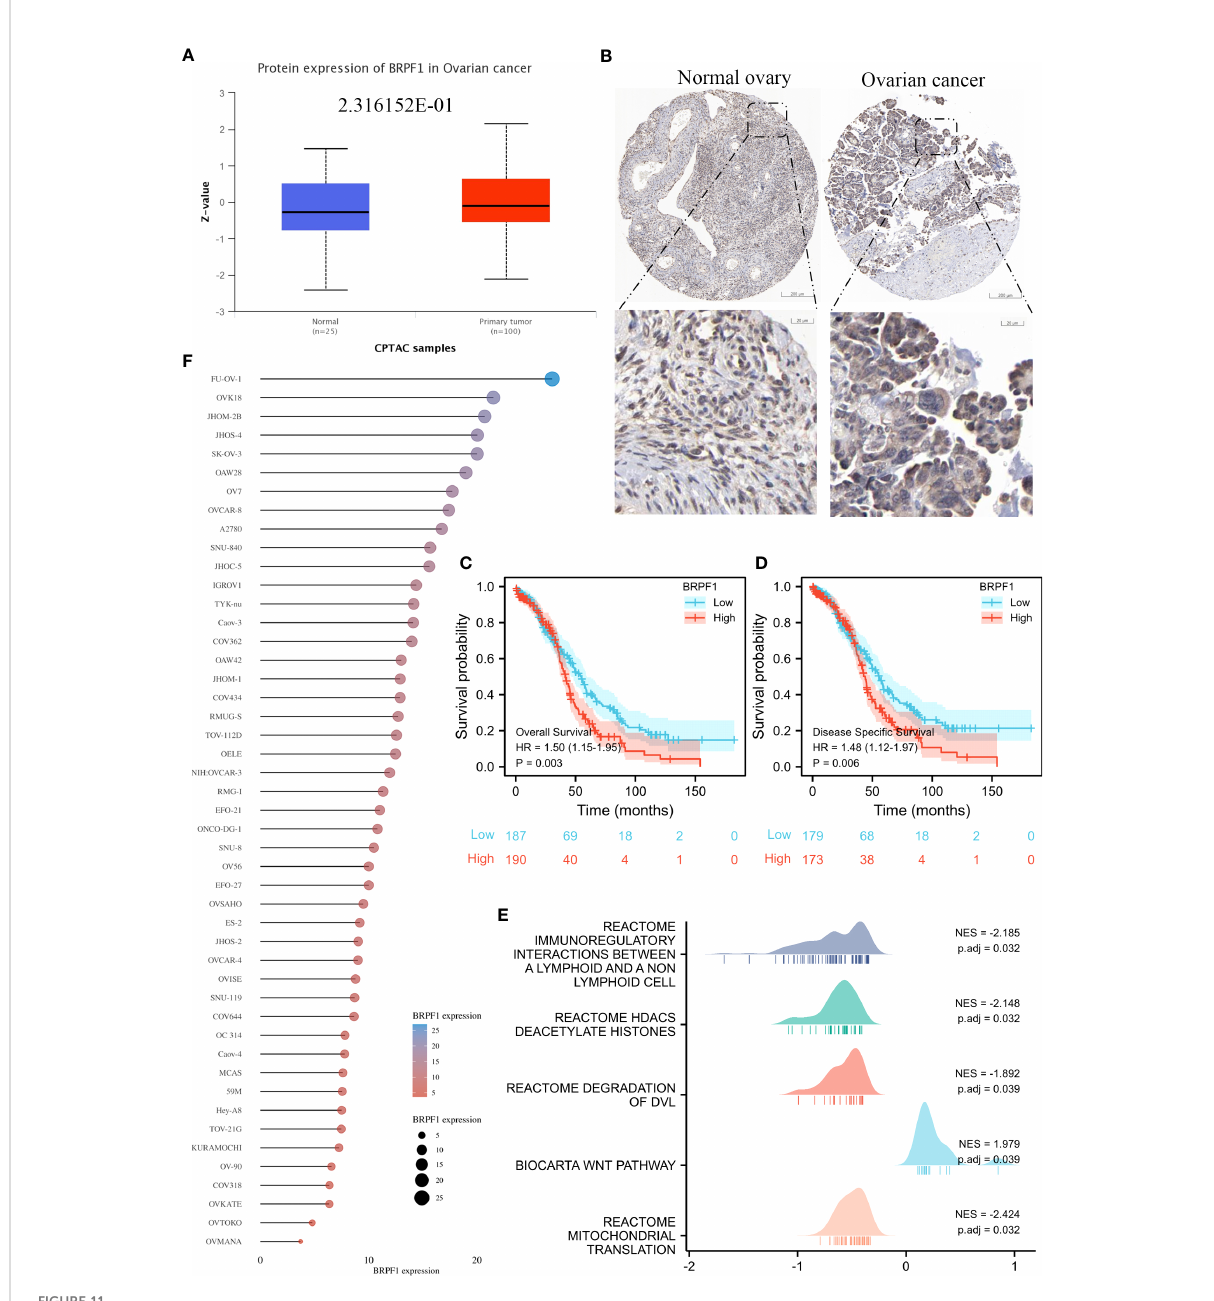
FIGURE 11 The expression, prognostic value and molecular function prediction of BRPF1 in OSC. (A) The total protein expression of BRPF1 in the CPTAC database. (B) The protein expression and lOSCation of BRPF1 in the HPA database. (C) Overall survival analysis of BRPF1 in OSC. (D) The disease-speci fi c survival analysis of BRPF1 in OSC. (E) GSEA of BRPF1 in OSC tissue samples. (F) The expression of BRPF1 in multiple OSC cell lines based on the CCLE